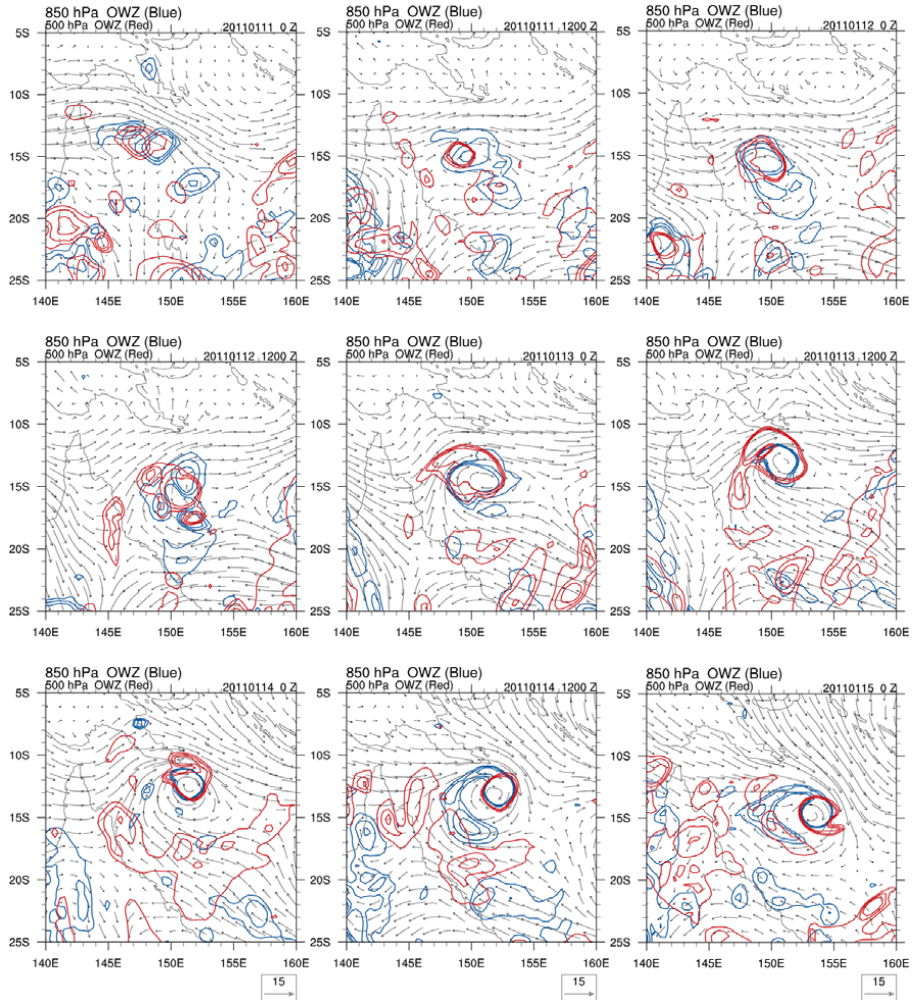
Figure 5. ACCESS analysis OWZ on the 850 hPa (blue contours, 60, 80, 100 6 1 10 s − − × ) and 4 Fig. 5. ACCESS analysis OWZ on the 850hPa (blue contours, 60, 80, 100 × 10 − 6 s − 1 ) and 500hPa (red contours, 50, 70, 90 × 10 − 6 s − 1 ) pressure levels, and 850hPa horizontal winds (vectors), at 12 hourly intervals for the 72 h leading up to the formation of TC Zelia (January 500 hPa (red contours, 50, 70, 90 6 1 10 s − − × ) pressure levels, and 850 hPa horizontal winds 5 2011) in the Coral (vectors), at 12 hourly intervals for the 72 hours leading up to the formation of TC Zelia 6 (January 2011) in the Coral Sea. 7